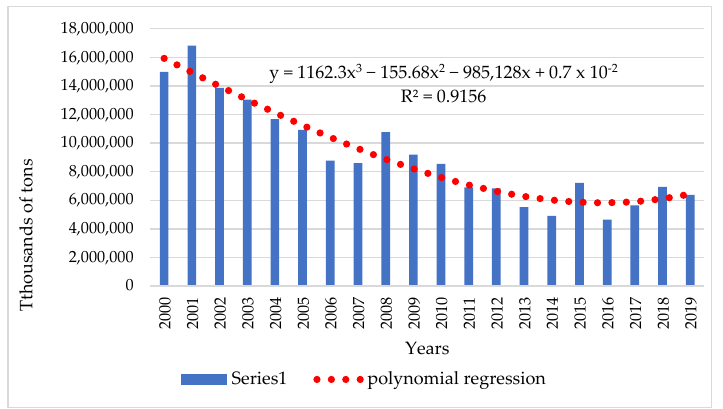
Figure 4. Changes in the total potato harvest in the southeastern part of Poland in 2000 – 2019.